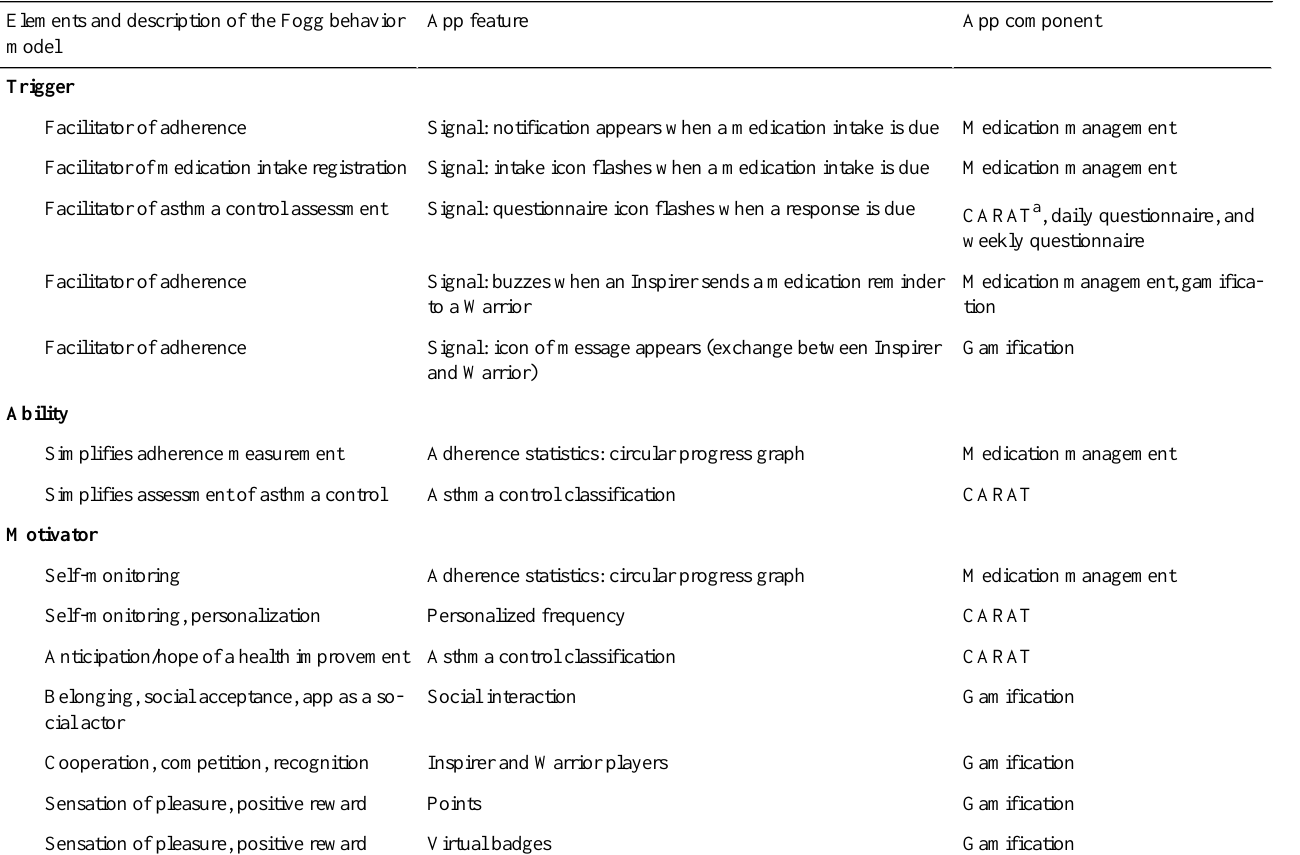
Table 1. Elements of the Fogg behavior model in the InspirerMundi app.